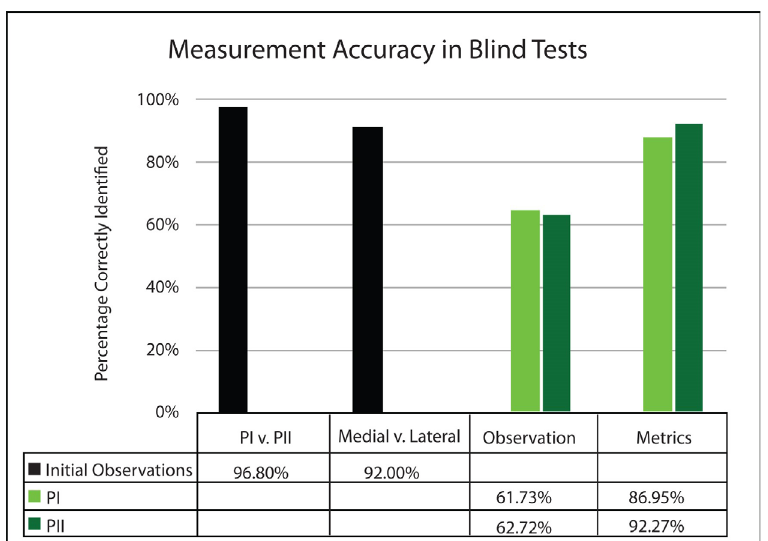
Figure 7. Graph of blind test results. Black bars represent Test A; light green, PI Test B; dark green, PII Test